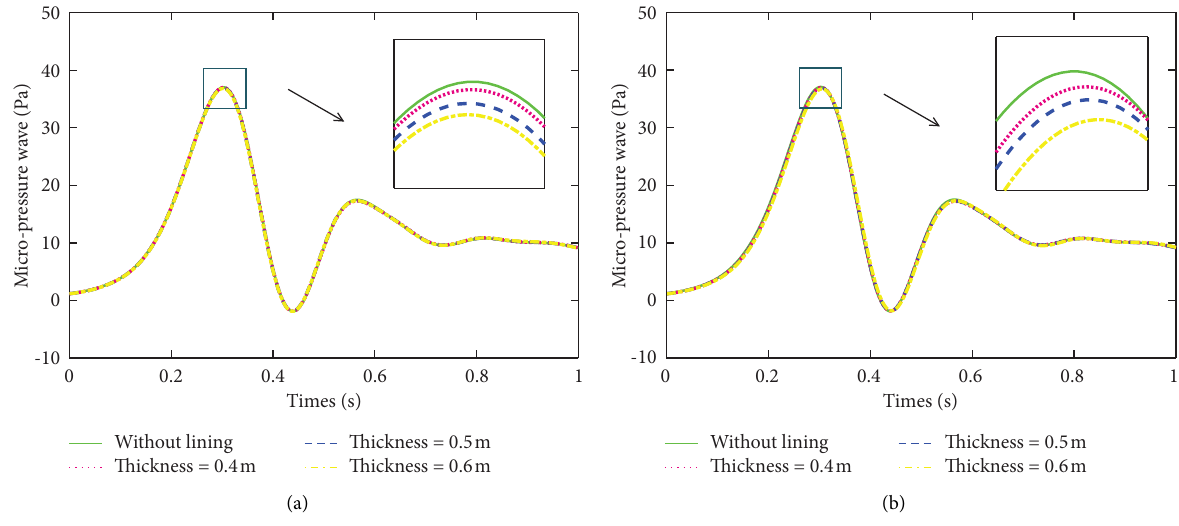
Figure 11: Comparison of the micropressure wave at M 3. (a) Normal linings. (b) 10-segment linings. Table 6: Comparison of amplitude values of the micropressure wave at M 1.